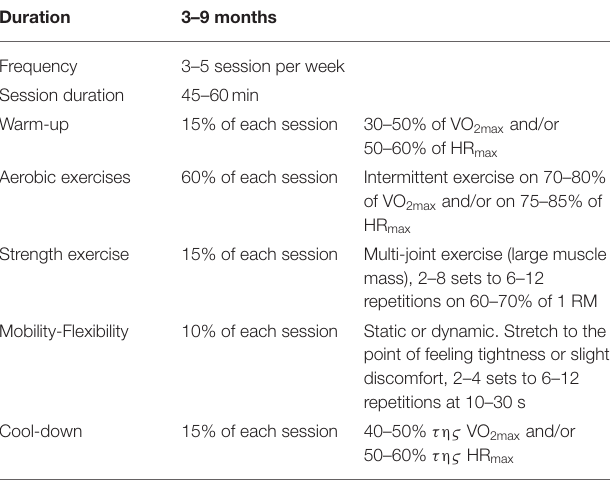
TABLE 1 | Recommended exercise program for patients with